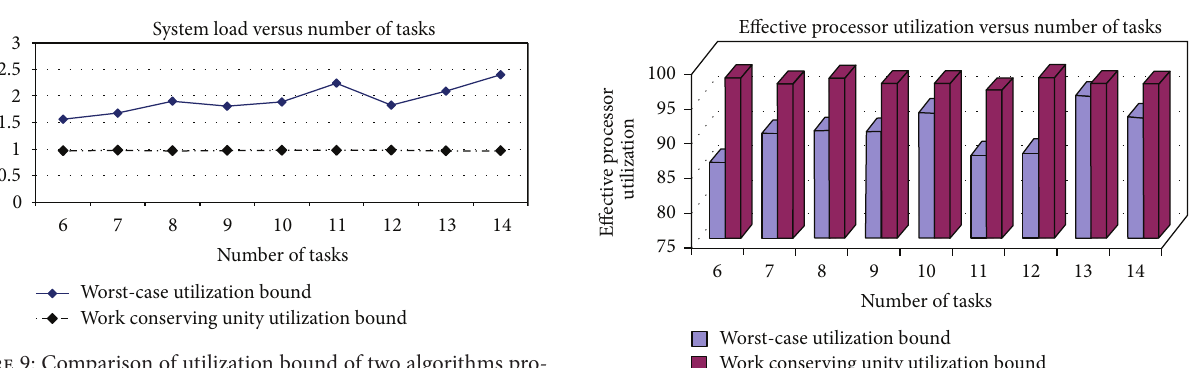
Figure 9: Comparison of utilization bound of two algorithms pro- posed.